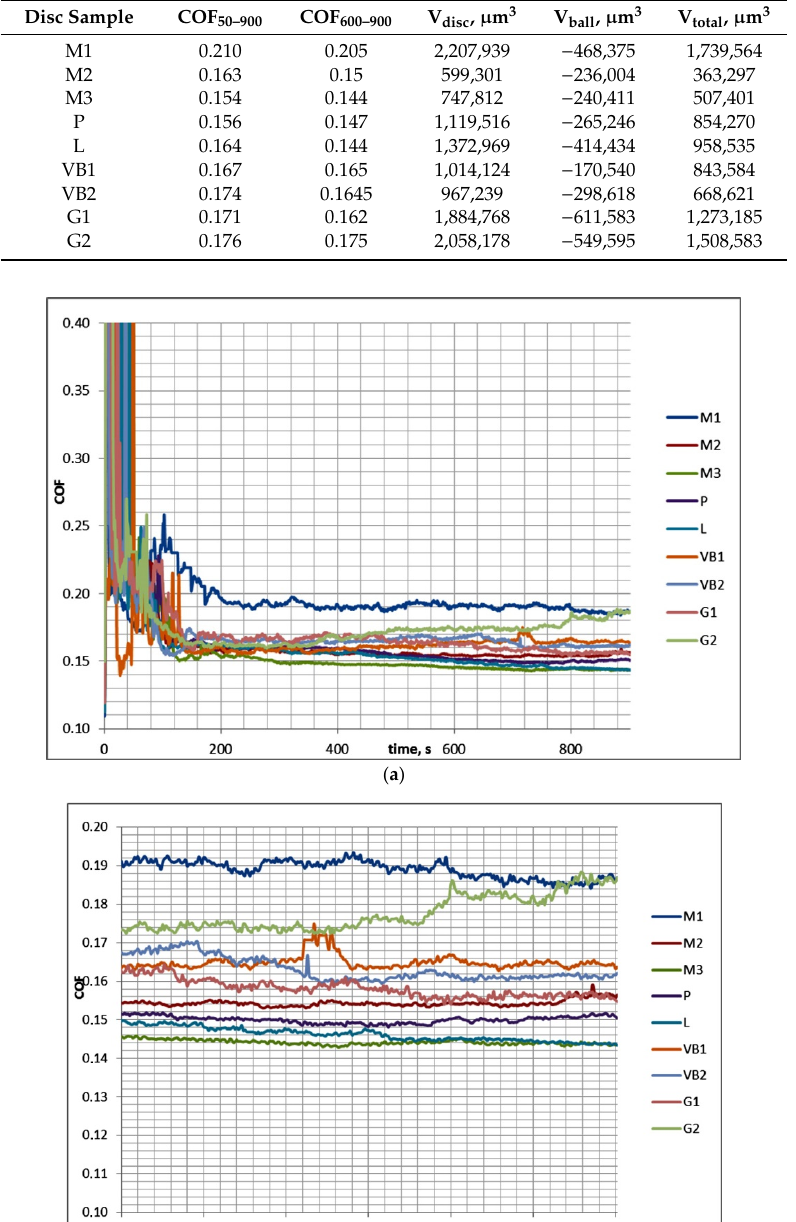
Table 7. Results of test D (f = 80 Hz, P = 100 N, temperature 90 °C, the number of cycles 72,000).